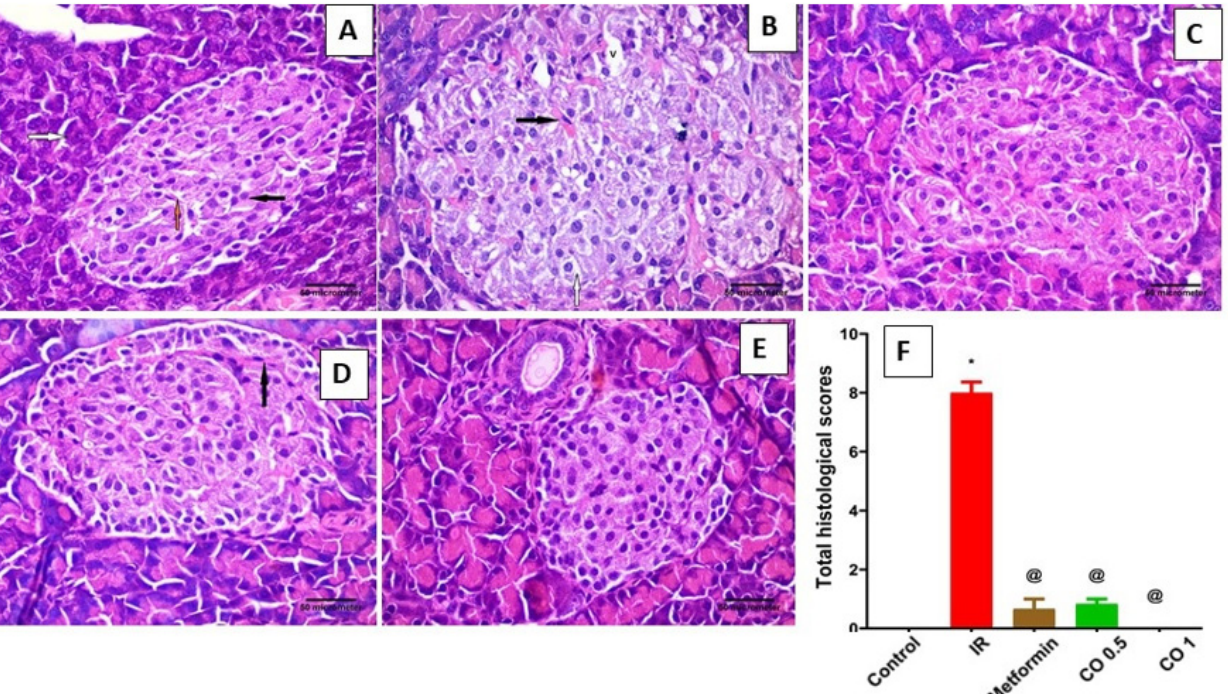
Figure 4. Effect of coriander oil and metformin on pancreatic tissue histology in dexamethasone- induced insulin resistance in rats (IR). ( A ) representative photomicrograph of control rat showing one pale stained islet of Langerhans rich in blood capillaries which are recognized by their flat basophilic endothelial nuclei (orange arrow). Endocrine cells have acidophilic cytoplasm and prominent nuclei at the center (black arrow). The pancreatic acini are lined by irregular triangular cells with basely located rounded nuclei (white arrow). Notice the apical acidophilic granules and the basal basophilia within the acinar cells; ( B ) representative photomicrograph of IR rat showing islet of Langerhans with multiple congested blood capillaries (black arrow), most cells with vacuolated cytoplasm (white arrow). Multiple vacuolations (V) can be seen within the islet; ( C ) representative photomicrograph of metformin (50 mg/kg/day, PO) treated IR rat displaying that the histological structure of the pancreas is like that of the control group; ( D ) representative photomicrograph of low dose coriander oil (0.5 mL/kg, PO) treated IR rat displaying the histological structure of the pancreas is like that in the control group but there is congested blood capillary (white arrow); ( E ) representative photomicrograph of high dose coriander oil (1 mL/kg, PO) treated IR rat displaying that the histological structure of the pancreas is like that in the control group. (H&E, ×400, scale bar = 50 μ m). ( F ) column graph represents total histologic scores of pancreases of different groups, data are expressed as mean ± SEM, n = 6, * , @ p < 0.05 compared to normal and the insulin resistance, (IR) groups respectively, by One Way ANOVA followed by Dunnett’s multiple comparisons test. Table 1. Histopathological changes in pancreas of different groups.